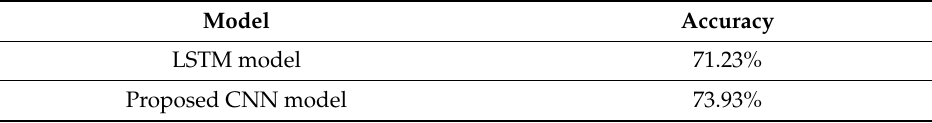
Table 3. Performance